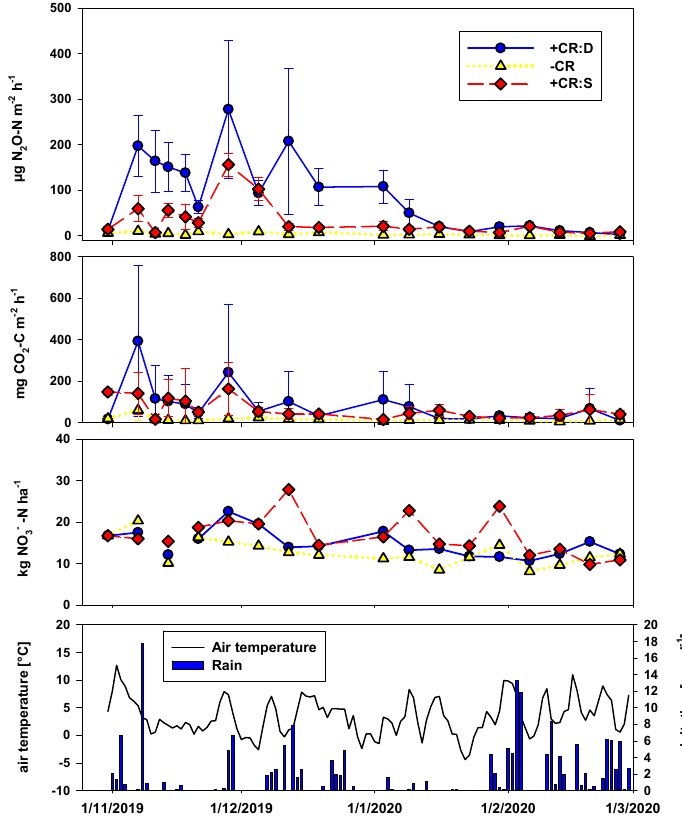
Figure 1. Mean N 2 O flux rates (n = 4 ± standard error), mean CO 2 flux rates ( ± standard error), and soil nitrate contents (0–0.3 m depth) as affected by sugar beet residue management and mean daily air temperature in 2 m height (black line) and daily precipitation (blue bars). +CR:D = residues ploughed in, − CR = residues removed from the field and +CR:S = residues surface applied after ploughing. Besides crop residues application, increased N 2 O fluxes were also measured after 11.5 mm rainfall on 28 and 29 November 2019, as well as after several smaller rainfall events in the second